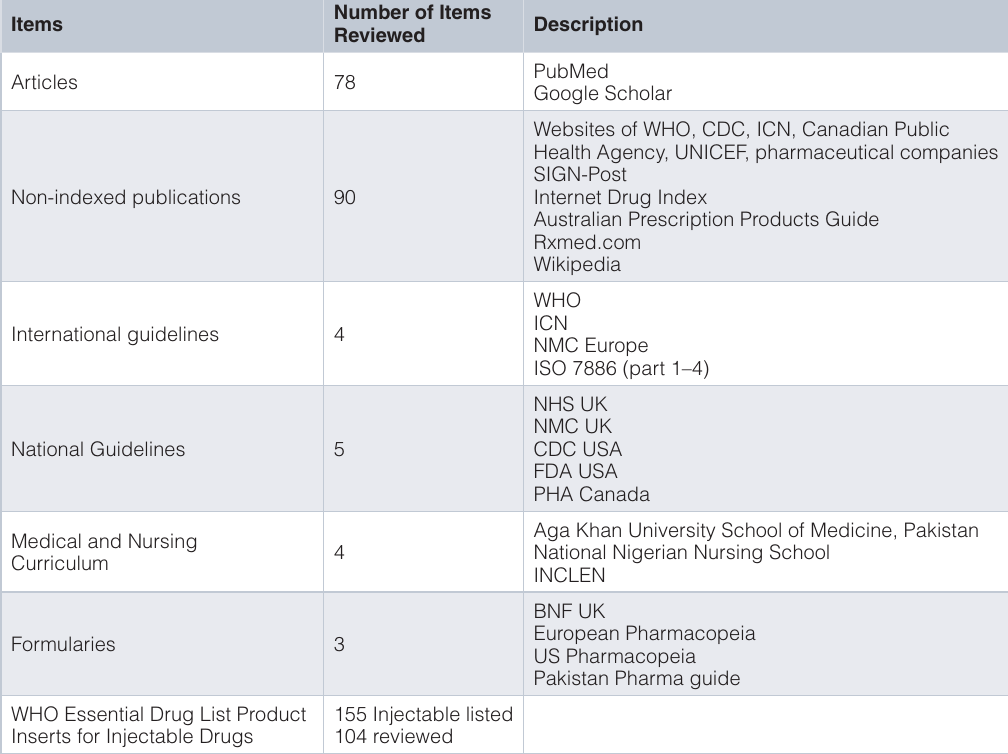
Table 1. Description of peer items reviewed with numbers reviewed.